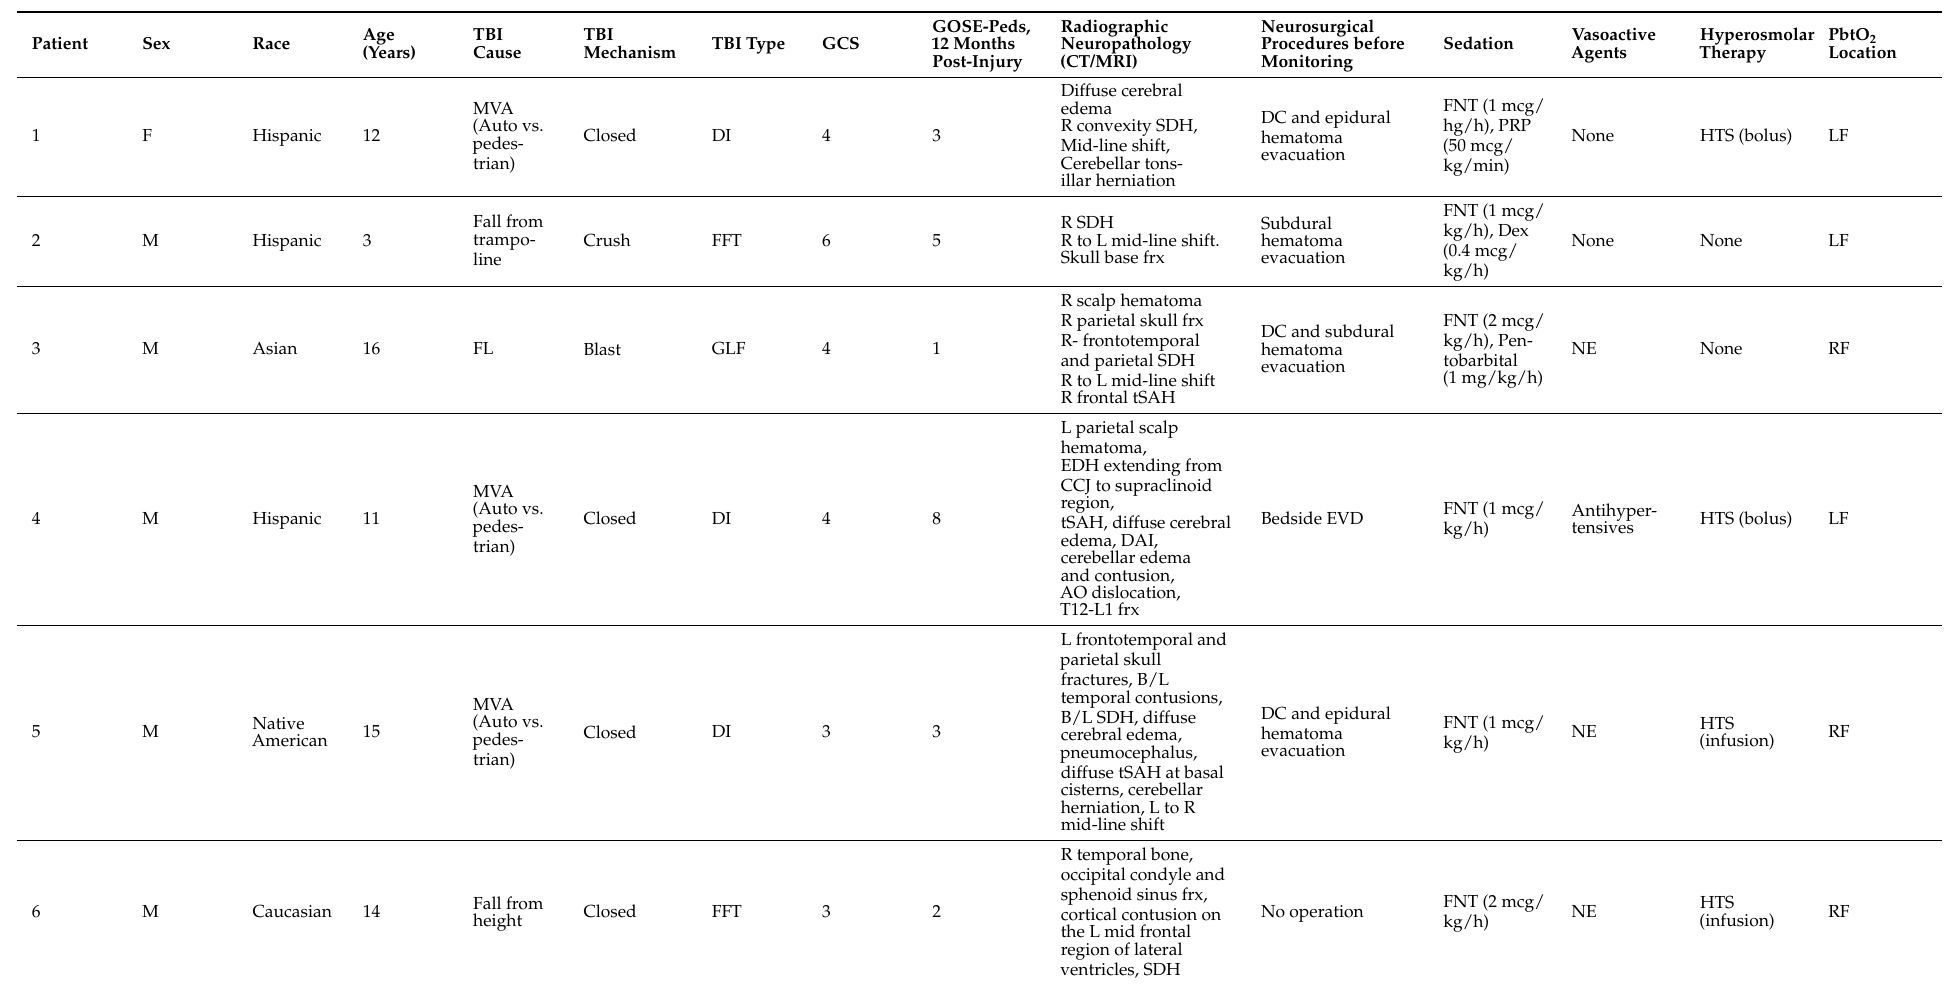
Table 1. Patient